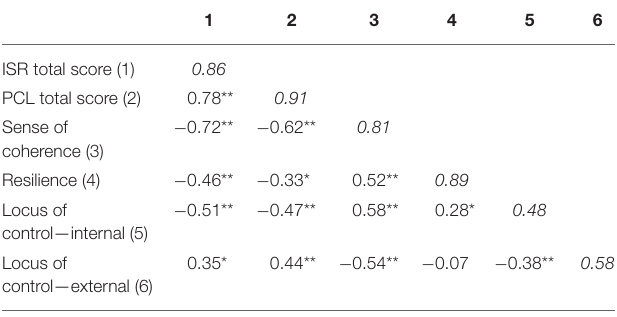
TABLE 4 | Bivariate correlations of all relevant variables. TABLE 5 | Multiple regression analysis of general mental health problems (ISR total score) and PTSD symptom severity (PCL total